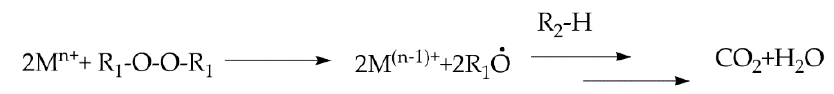
Figure 4. Schematic processes of the organic molecule degradation mediated by peroxides.